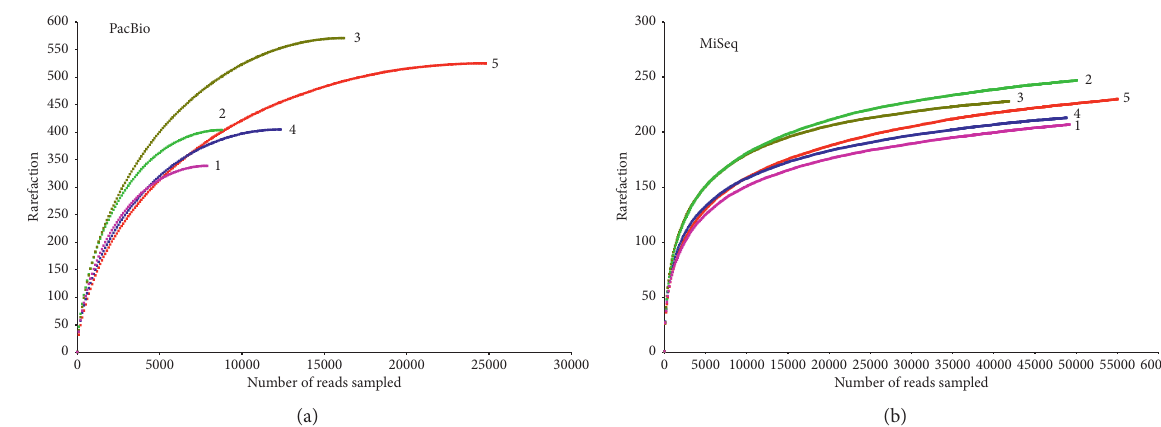
Figure 2: Rarefaction curves for (a) PacBio and (b) MiSeq platforms. The average number of OTUs in each sample was calculated. Samples from the two platforms displayed similar phylogenetic diversity at a 97% identity